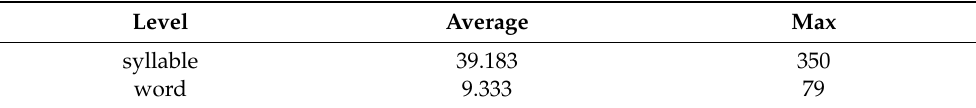
Table 2. The average and maximum value of the number of syllables and words in each sentence.